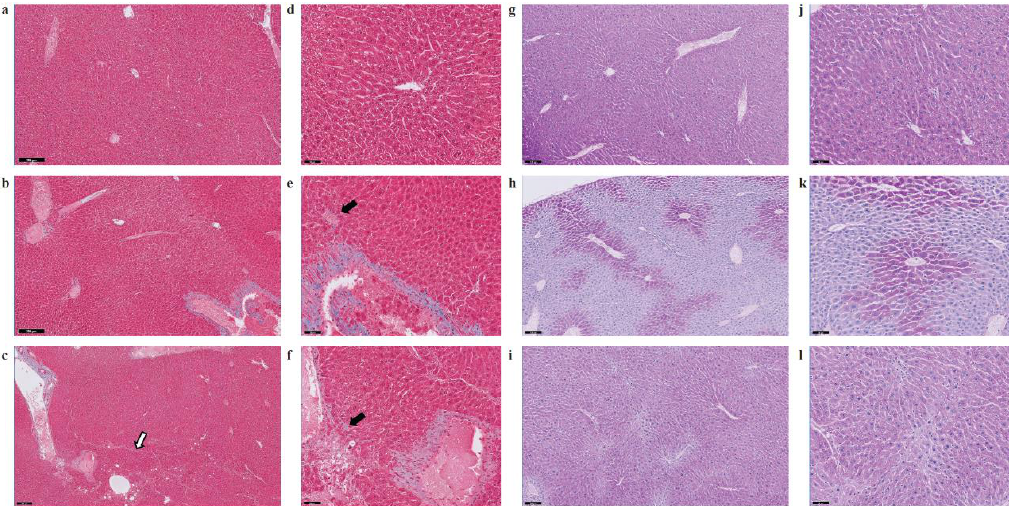
Figure 5. Evaluation of liver fibrosis and glycogen deposition in SHS-exposed mice. Paraffin-embedded liver sections from experimental and control mice were stained with Masson’s trichrome ( a – f ) and Periodic Acid-Schiff (PAS) stain ( g – l ) to evaluate fibrosis and glycogen deposition, respectively. Representative microphotographs are shown at low (scale bar, 200 μM) and high magnifications (scale bar, 50 μM). Panels a , d , g , j , control mice; panels b , e , h , k , SHS 4m mice; panels experimental mice. The white arrow shows an area of pronounced liver steatosis. Black arrows